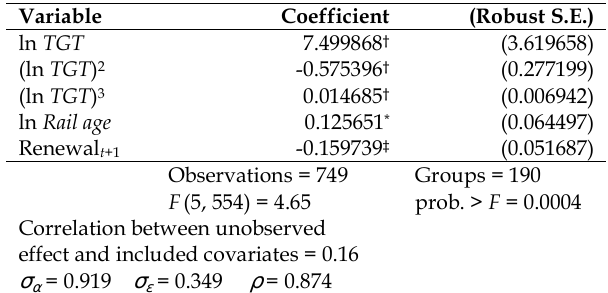
Table 2. Results from a FE model for infrastructure maintenance costs and a renewal dummy